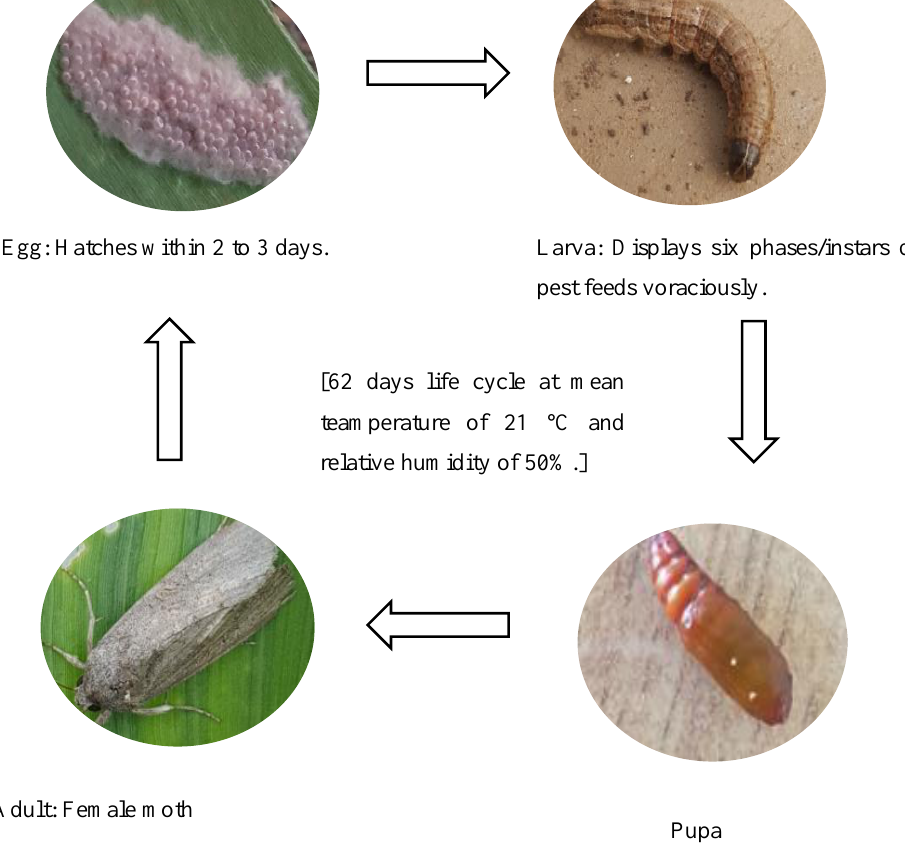
Figure 1. The life cycle of FAW with the egg, larva, pupa and adult stages.